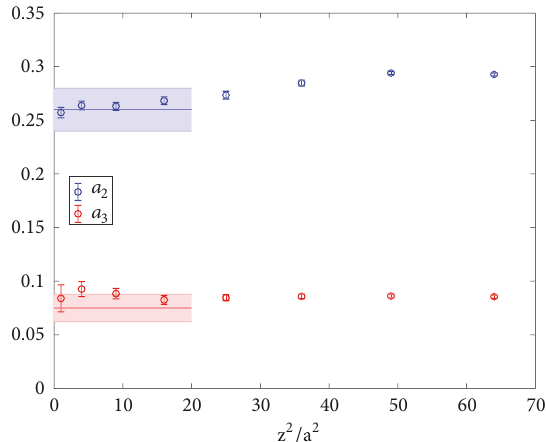
Figure 37: The first (blue) and second (red) lowest moments of the isovector unpolarized PDF obtained from a quenched ensemble with 𝑎 ≈ 0.093 fm and valence pion mass of approximately 600 MeV. The data points come from the pseudodistribution approach at different values of 𝑧 2 and the shaded bands correspond to an earlier explicit computation by the QCDSF collaboration [230]. Source: [90] (arXiv), reprinted with permission by the